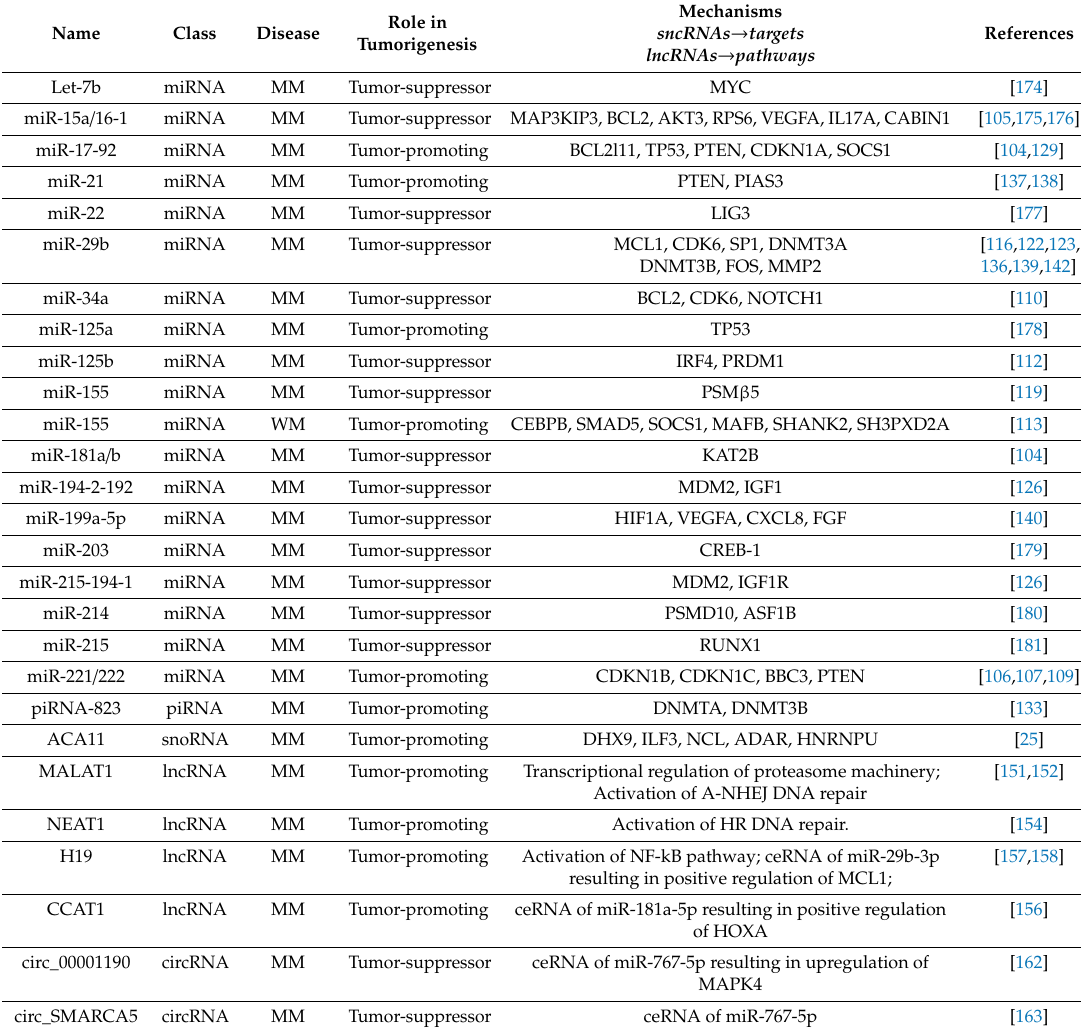
Table 2. Functionally characterized ncRNAs in PC